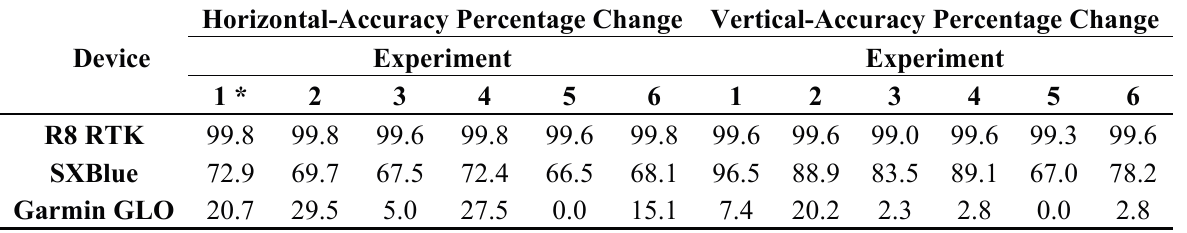
Table 6. Improvement rate of accuracy on checkpoints based on different GCP